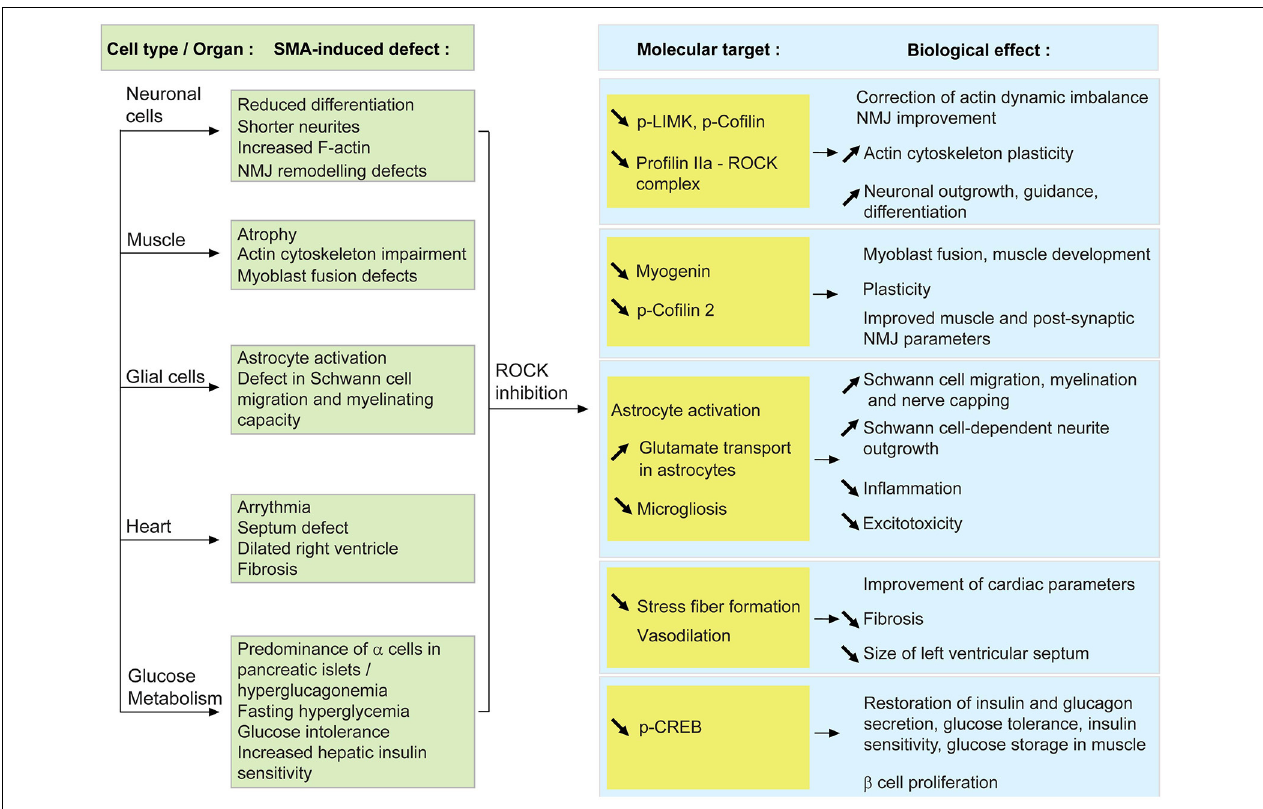
FIGURE 2 | Proposed model of how systemic ROCK inhibition in SMA mice may result in beneficial effects within several cells and tissues. When SMN is depleted, the activity of the RhoA/ROCK pathway is increased which leads to several cellular defects (described in the green boxes). Upon